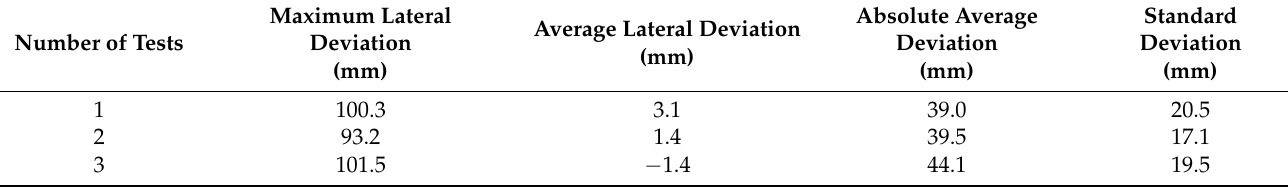
Table 14. Statistics of straight-line path lateral deviation.